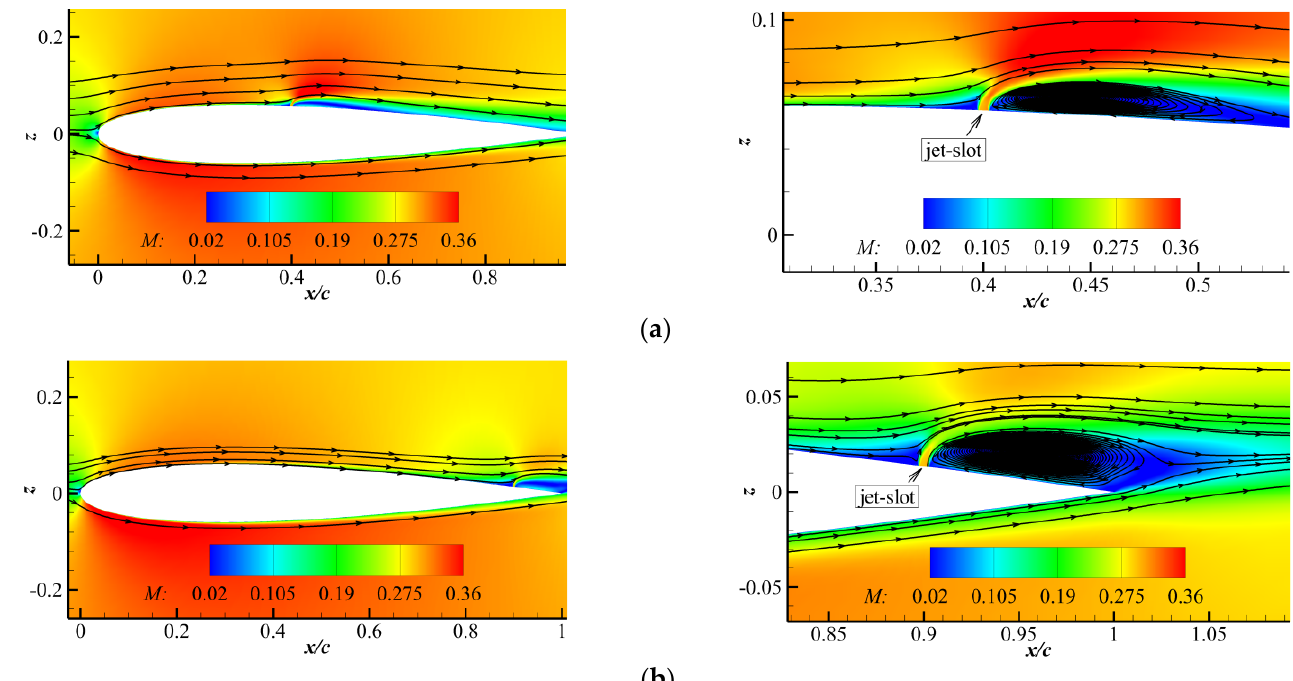
Figure 5. Velocity flow fields and streamlines of the baseline model and models with microjet blowing for M jet = M ∞ = 0.3, at α = 0° (from [30]). ( a ) Microjet blowing, x/c = 0.4 ; ( b ) microjet blowing, x/c = 0.9.